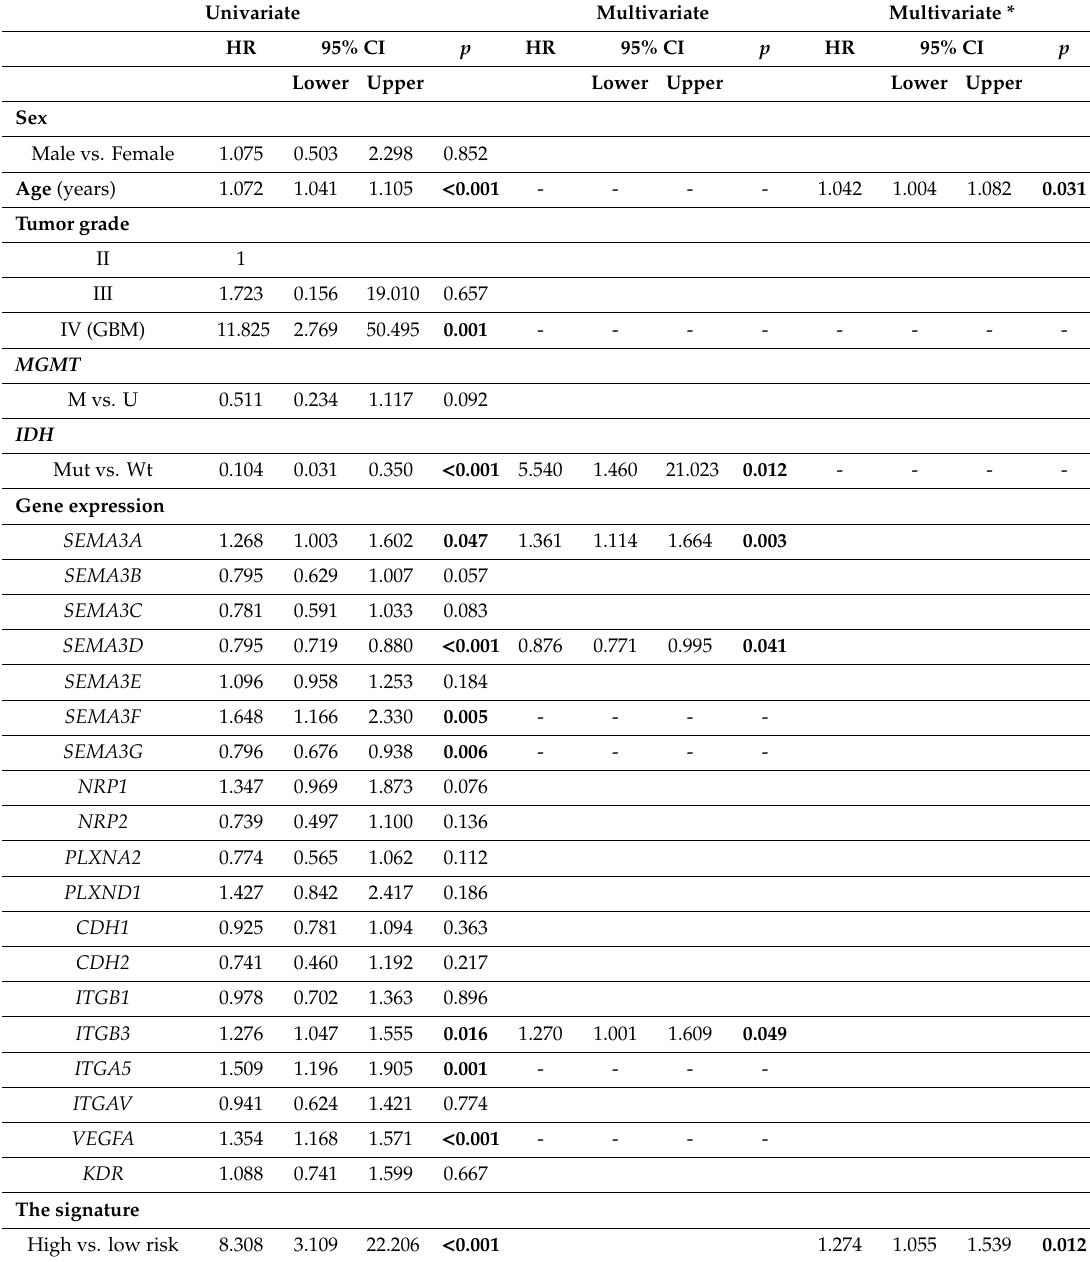
Table 2. Univariate and multivariate Cox regression analysis in training cohort. Univariate Multivariate Multivariate